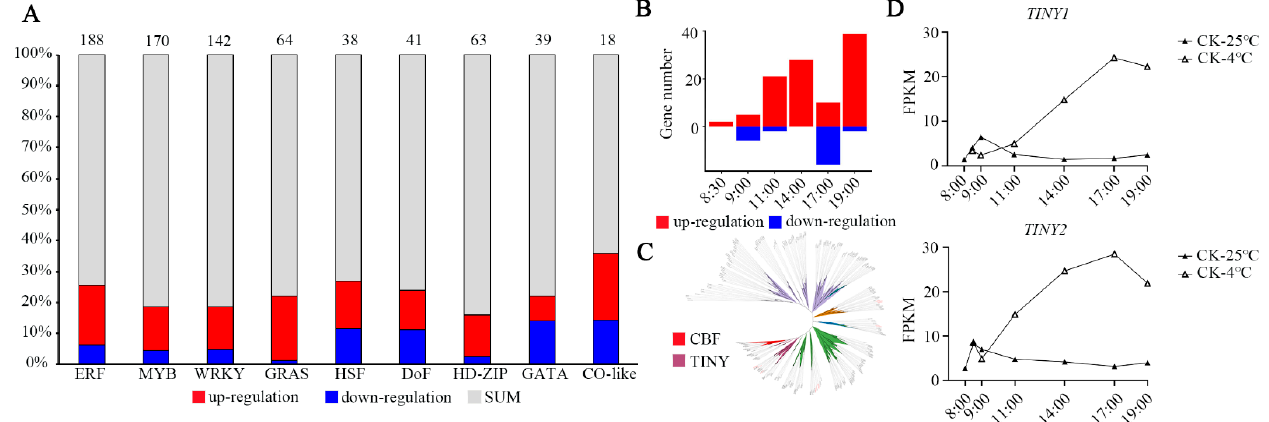
Figure 4. The dynamics of cold-regulated differentially expressed TFs. ( A ) The number of differen- tially expressed transcription factors after cold treatment. ( B ) The number of differentially expressed genes in ERF family after cold treatment. ( C ) ERF family phylogenetic tree in Setaria viridis and Arabidopsis thaliana . ( D ) The expression of TINY1 and TINY2 at the six time points. Transcriptome analysis indicated that only 12% of COR genes are directly controlled